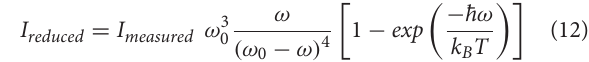
FIGURE 1 | Probability of crack initiation (PCI) as a function of the applied Vickers indentation load for glass Si60P7.5. The inset shows the typical crack pattern observed after Vickers indentation (load 19.6N). The orange dashed line illustrates the sigmoidal fit used to determine crack resistance (defined as the load at PCI 50%). Connecting the end points of the PCI error bars = creates an approximated error envelope. The intersections of this error envelope with the 50% PCI line were used to estimate the experimental uncertainty in crack resistance.